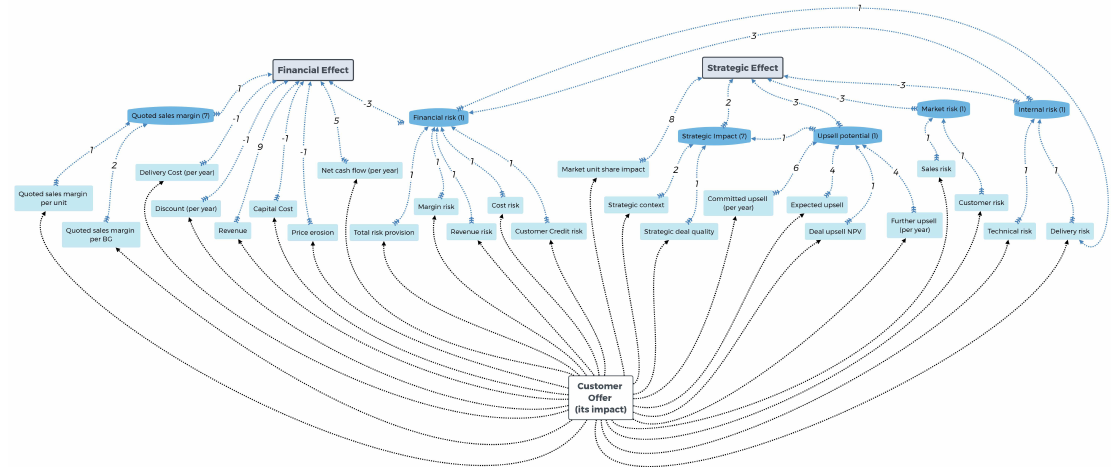
Figure 2. Case-study model: In the context of FCM and